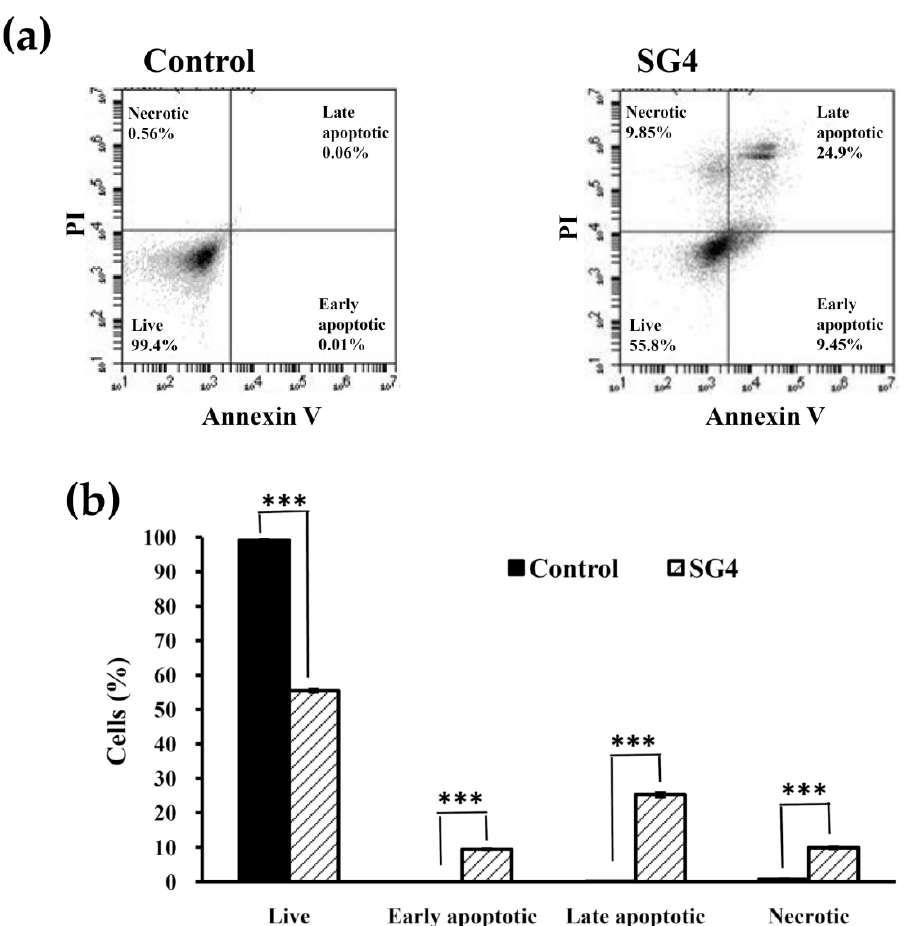
Figure 6. The annexin V-FITC / PI staining analysis of HT-29 cells treated with 200 µ g / mL SG4 for 48 h: ( a ) In the histograms, annexin-V fluorescence is displayed on the x axis and PI fluorescence on the y axis. The percentage of cells on each boundary (live, early apoptotic, late apoptotic, and necrotic) is indicated in each histogram; ( b ) the percentage of live, early apoptotic, late apoptotic, and necrotic cells is presented as determined for ( a ). The experiments were performed in triplicate. *** p < 0.001.